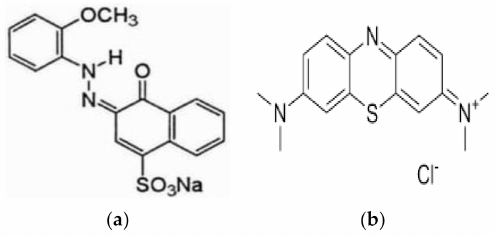
Figure 1. Chemical structures of: ( a ) Acid Red 4 ( b ) Methylene